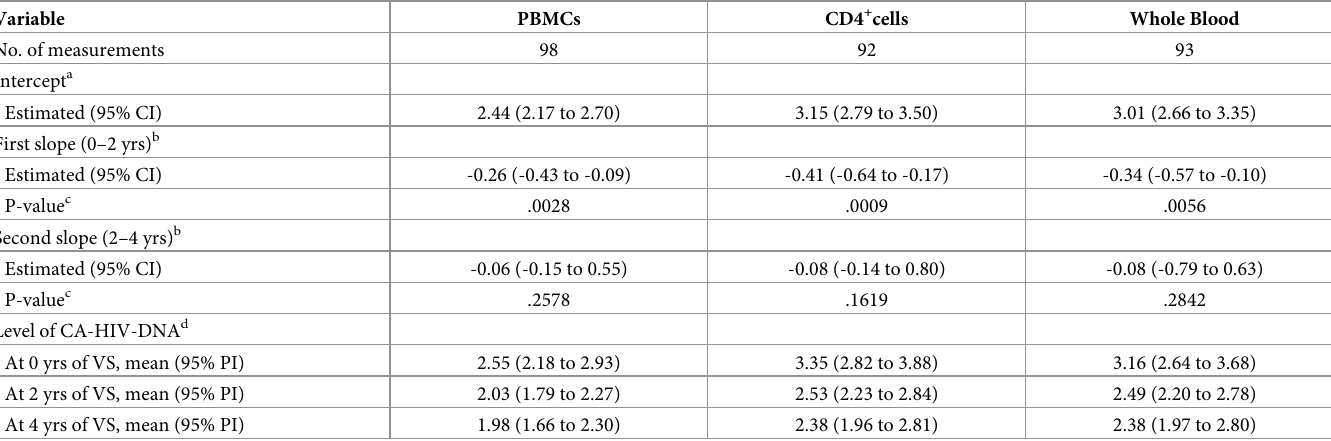
Table 2. Estimated decay rates and predicted means of cell-associated HIV-1 DNA level over 4 years of sustained viral suppression and expressed in different units.